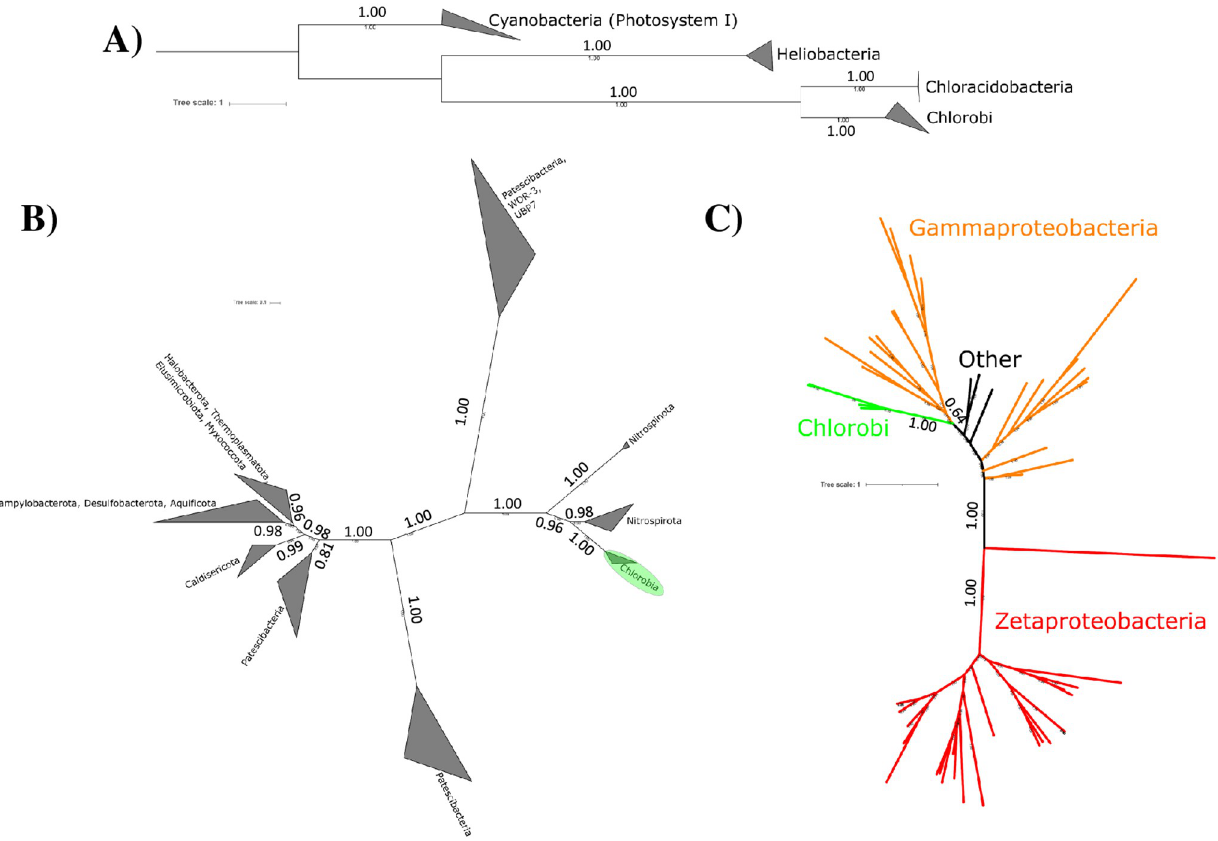
Fig 3. Phylogenies of metabolic proteins discussed in the text; congruence of metabolic protein phylogenies with organismal phylogenies (e.g. those derived from concatenated ribosomal proteins such as in Fig 2) suggests vertical inheritance of traits from the last common ancestor, whereas incongruent topologies suggest a history of horizontal gene transfer of metabolic pathways. A) Phylogeny of type 1 reaction centers, showing broad topological congruence with organismal relationships shown in Fig 2; together with the synapomorphic distribution of phototrophy in the Chlorobia, this suggests that phototrophy was acquired in stem group Chlorobia and has since been vertically inherited. B) Phylogeny of ATP citrate lyase, a key marker gene for the capacity for carbon fixation via the rTCA pathway. Phylogenetic relationships of this gene within the Chlorobia are congruent with organismal relationships, suggesting that this trait has been vertically inherited in most Chlorobi (with the exception of loss in aerobic members of the Chloroherpetonaceae). However, ATP citrate lyase in Chlorobi appears to be derived from genes of nitrite oxidizing bacteria (Nitrospirota and Nitrospinota), suggesting that this trait was acquired by Chlorobi via horizontal gene transfer after the radiation of nitrite oxidizers. C) Phylogeny of Cyc2 cytochrome proteins associated with iron oxidation in Chlorobi and Zetaproteobacteria. Cyc2 genes in the Chlorobi appear to be derived from those of Proteobacteria, suggesting that the capacity for iron oxidation was acquired by Chlorobi via horizontal gene transfer after the radiation of aerobic iron oxidizing bacteria.